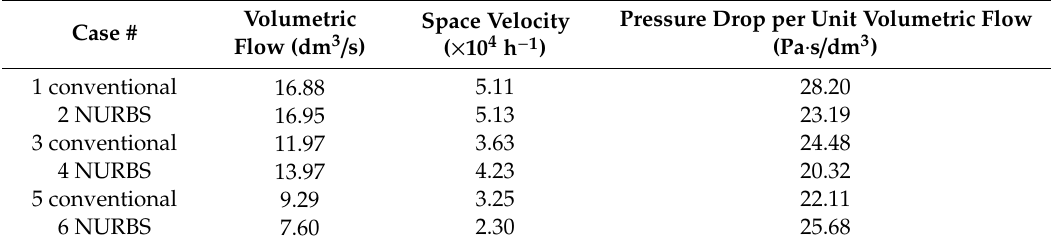
Table 5. Comparison of the pressure drop per unit volumetric flow. Table 5 . Comparison of the pressure drop per unit volumetric flow.